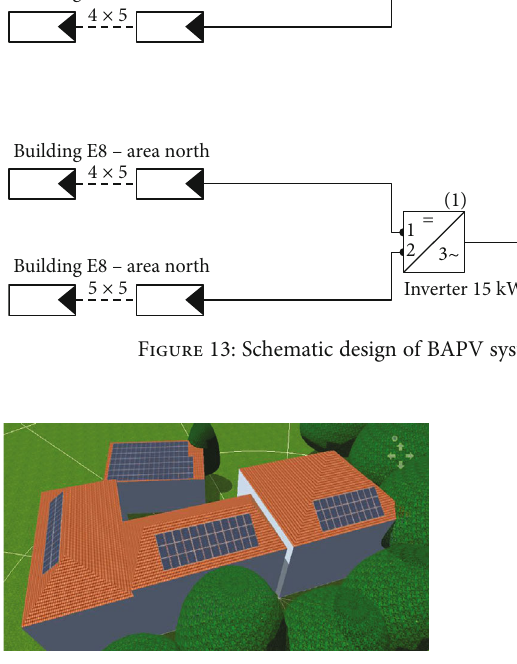
Figure 14: Architectural from top view at project site (BAPV system design for E11 Building).